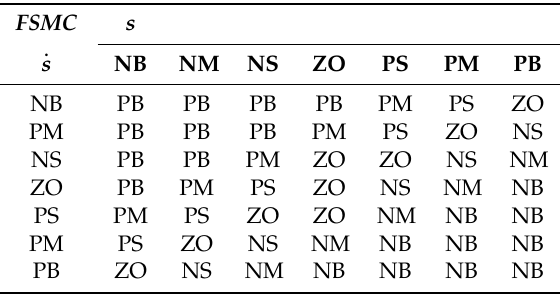
Table 2. Fuzzy rules for the fuzzy sliding mode controller ( FSMC) i .